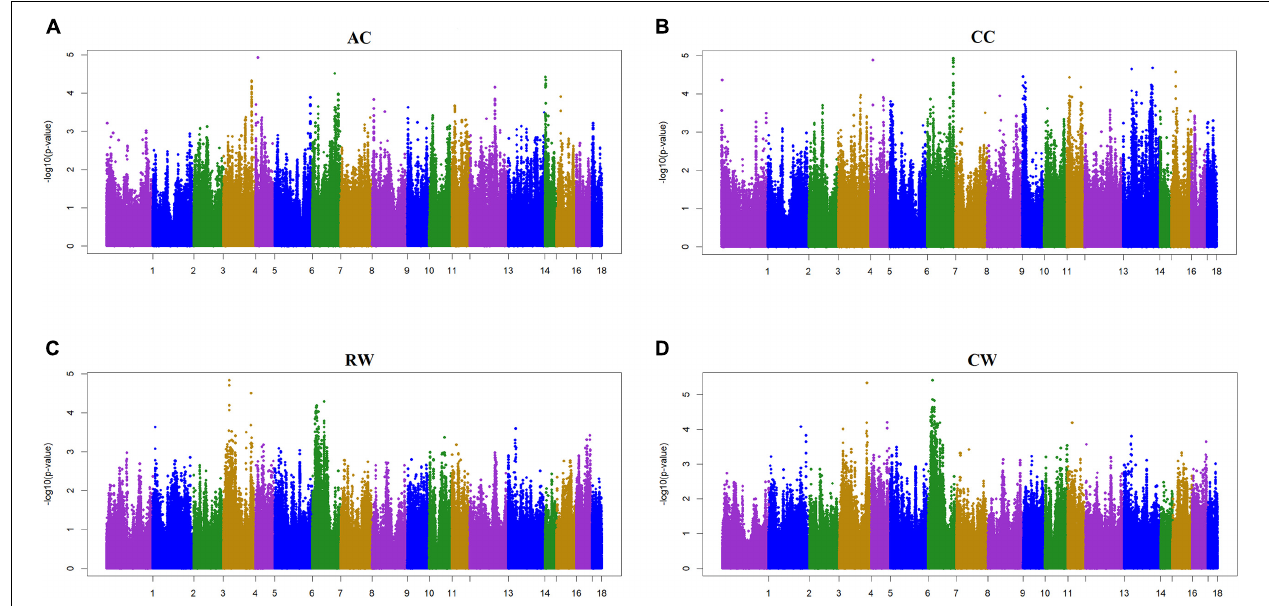
FIGURE 2 | Manhattan plot of the genome-wide association study on four body size traits by using two-trait model ssGWAS. AC, Abdominal circumference; CC, Chest circumference; RW, Rump width; CW, Chest width. AC and CC are a pair of traits, RW and CW are a pair of traits. In the Manhattan plots, negative log10 P -values of the quantified SNPs were plotted against their genomic positions. The x -axis represents the chromosomes and the y-axis represents the observed –log10( P -value). Different colors indicate various chromosomes. Each trait has a significant threshold of FDR adjusted, for (A) AC, it was 9.74 × 10 − 6 . Similarly, (B) CC was 1.05 × 10 − 5 , (C) RW was 9.60 × 10 − 6 , and (D) CW was 1.01 × 10 − 5